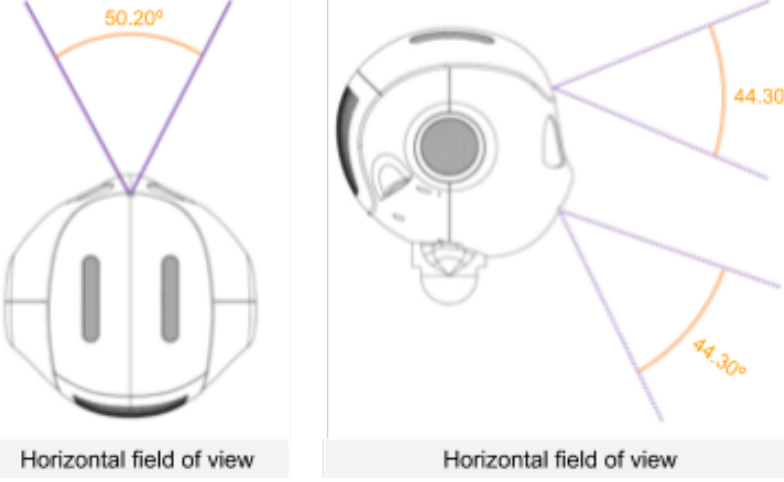
Figure 3. Pepper’s RGB cameras position and orientation.